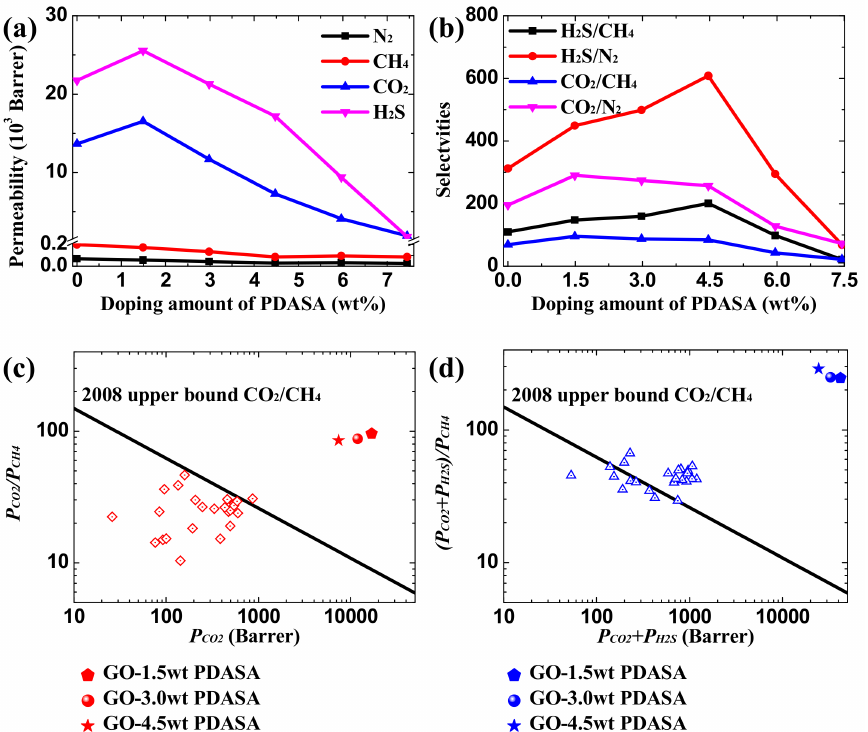
Figure 7. Separation performance. ( a ) Gas permeability. ( b ) Ideal selectivities of H 2 S/CH 4 , H 2 S/N 2 , CO 2 /CH 4 and CO 2 /N 2 . Performance comparison for separations of ( c ) CO 2 /CH 4 and ( d ) (CO 2 + H 2 S)/CH 4 with other potential membranes and the 2008 Robeson upper bound of CO 2 /CH 4 (Black